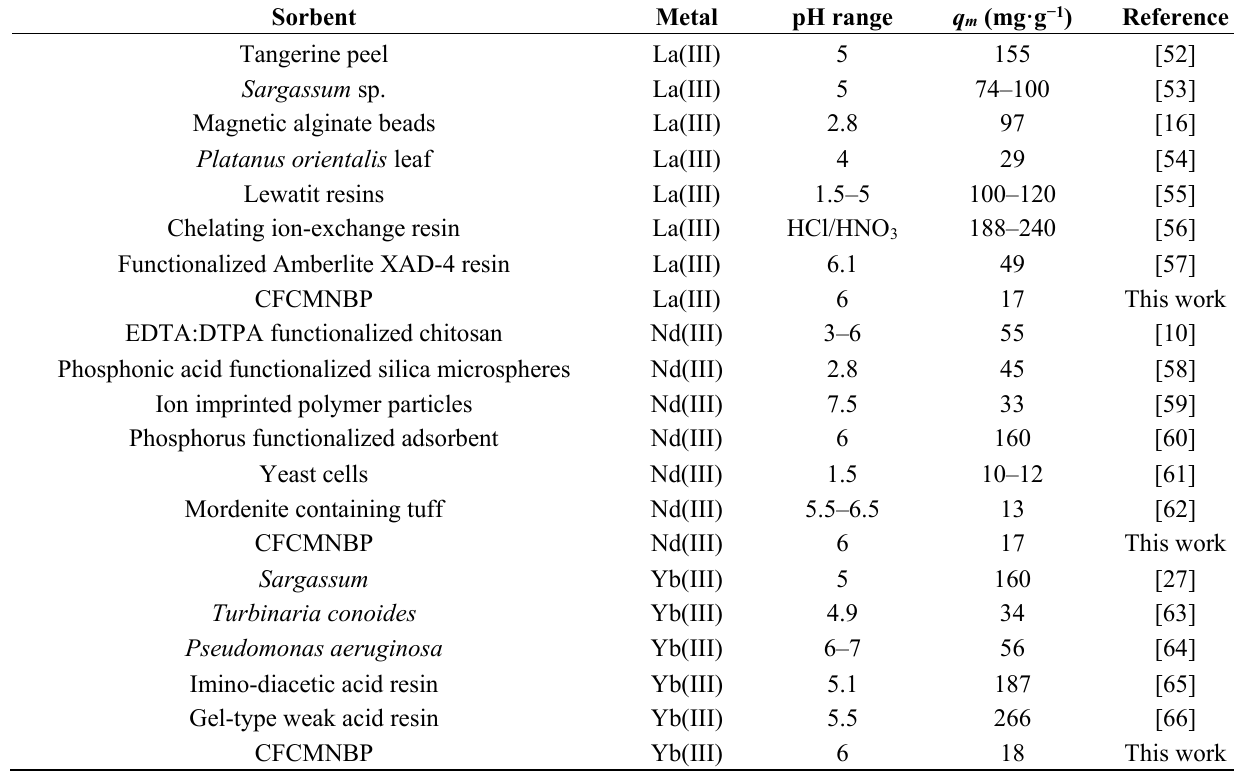
Table 6. Comparison of the La(III), Nd(III) and Yb(III) sorption properties of